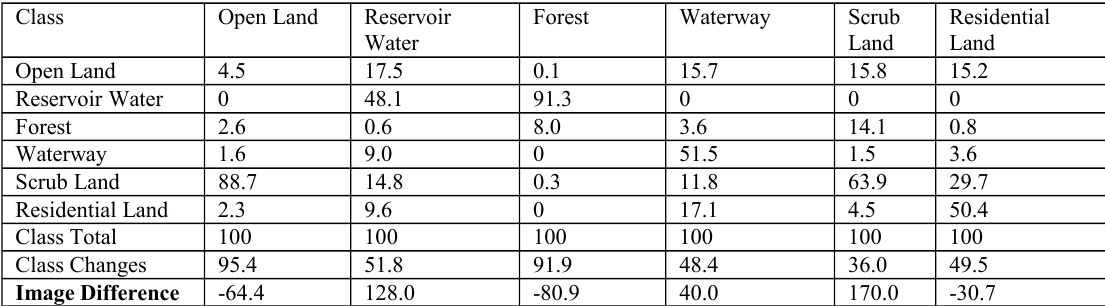
Table 2: Winter to Spring Season Change Detection